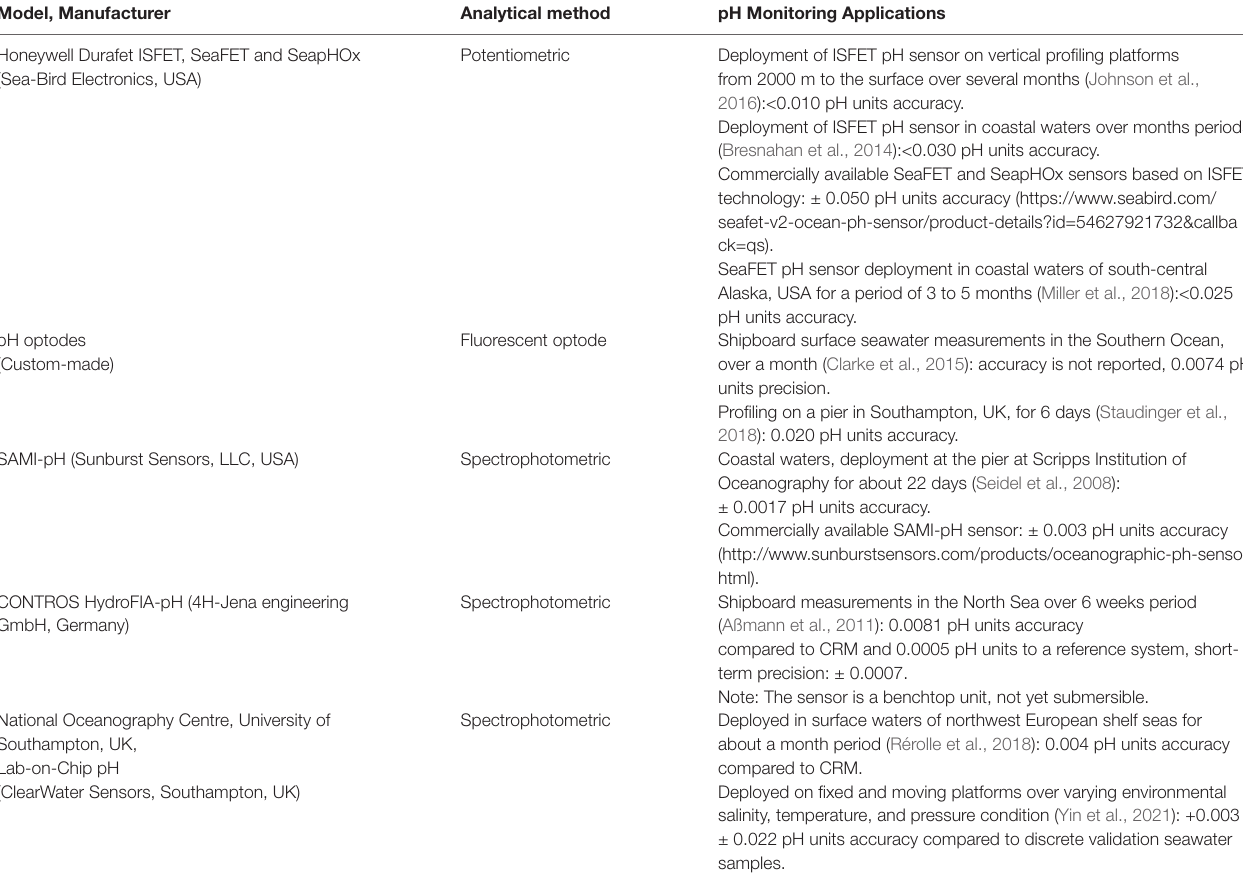
TABLE 1 | Examples of the current in situ pH sensors used in oceanographic